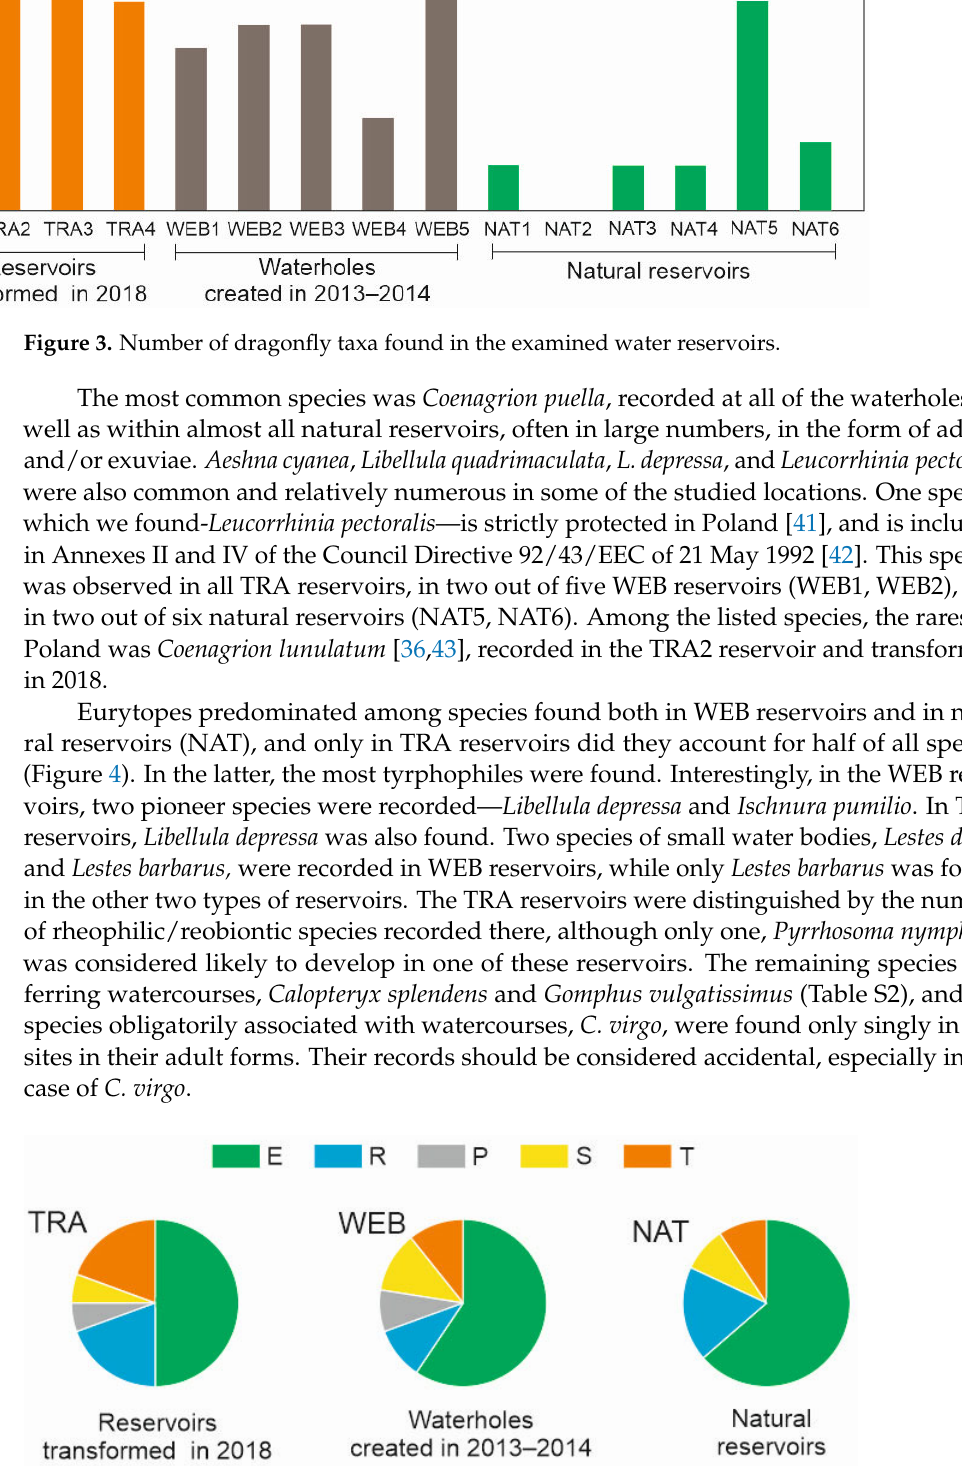
Figure 4. Ecological elements in the dragonfly fauna found in the examined water reservoirs: E- eurytopes; R-rheobionts and rheophiles; P-pioneer species; S—species of small water bodies; T- tyrphophiles.